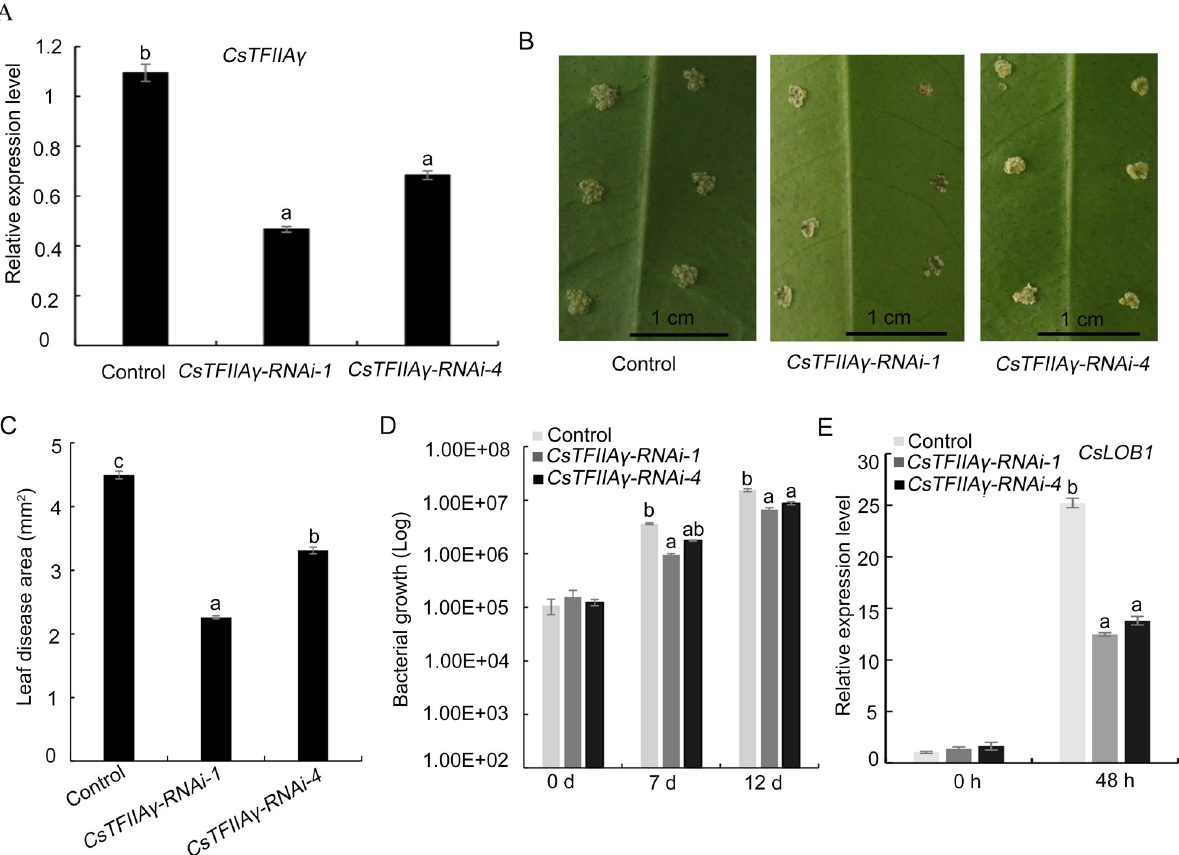
Fig 5. Enhancement of sweet orange resistance to Xcc through CsTFIIA γ RNA interference. (A) Relative expression levels of CsTFIIA γ in CsTFIIA γ -RNAi group and control group. (B) Symptoms of CsTFIIA γ - silencedlines (RNAi-1 and RNAi-4) and control leaves after inoculation with Xcc (10 8 CFU/mL). The photos were taken at 12 d after inoculation. (C) Disease lesion area on CsTFIIA γ -silenced lines and control leaves at 12 d after inoculation. The disease lesion area was calculated by ImageJ 2.0. (D) Bacterial growth in CsTFIIA γ -RNAi plants and control plants at 0, 7, and 12 d after inoculation. (E) Relative expression level of CsLOB1 at 48 h after inoculation. Data from three independent replicates were expressed as mean ± SD. Different letters above the bars represent significant differences (P < 0.05) in Duncan’s multiple range test.